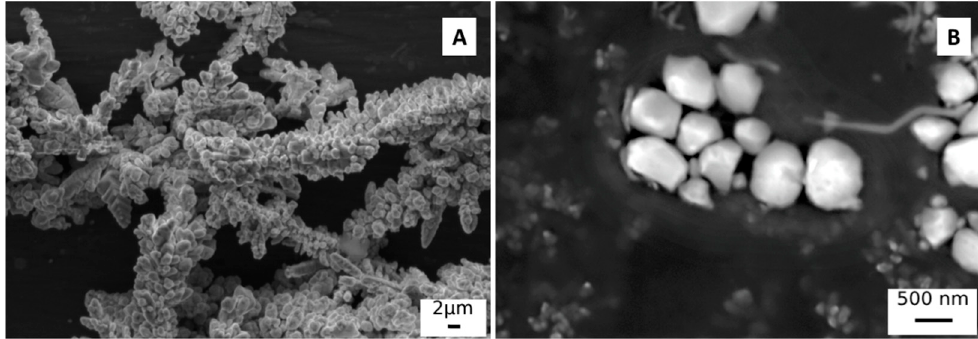
Figure 1. SEM image of the “large” copper particles ( A ) and of the “small” copper particles ( B ). The DC generator used for the PEO coating is a TDK Lambda power supply (TDK- Lambda, Achern, Germany) capable of delivering 2400 W (315 V, 8 A). During the treatment the sample worked as an anode while the cathode was made up of a carbon steel cage. The treatments were performed in galvanostatic mode. Two different operating modes were tested. (a) Direct Current (DC) mode: Current density 0.5 A/cm 2 in direct current. (b) Unipolar Pulsed Current mode (UPC): 1 A/cm 2 in pulsed current (with a frequency of 20 Hz and a duty cycle of 50%). Higher current density was employed in the samples obtained in UPC mode due to compensation of the off-time present in pulsed mode, in order to obtain coatings with similar thickness.